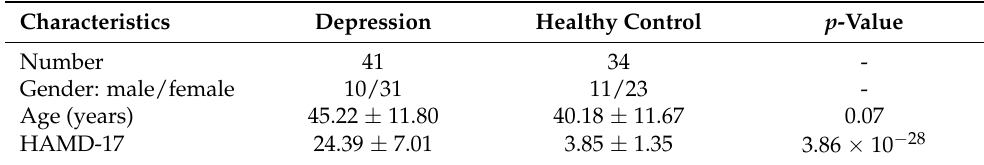
Table 1. Clinical characteristics of the patients with depression and healthy controls. Characteristics